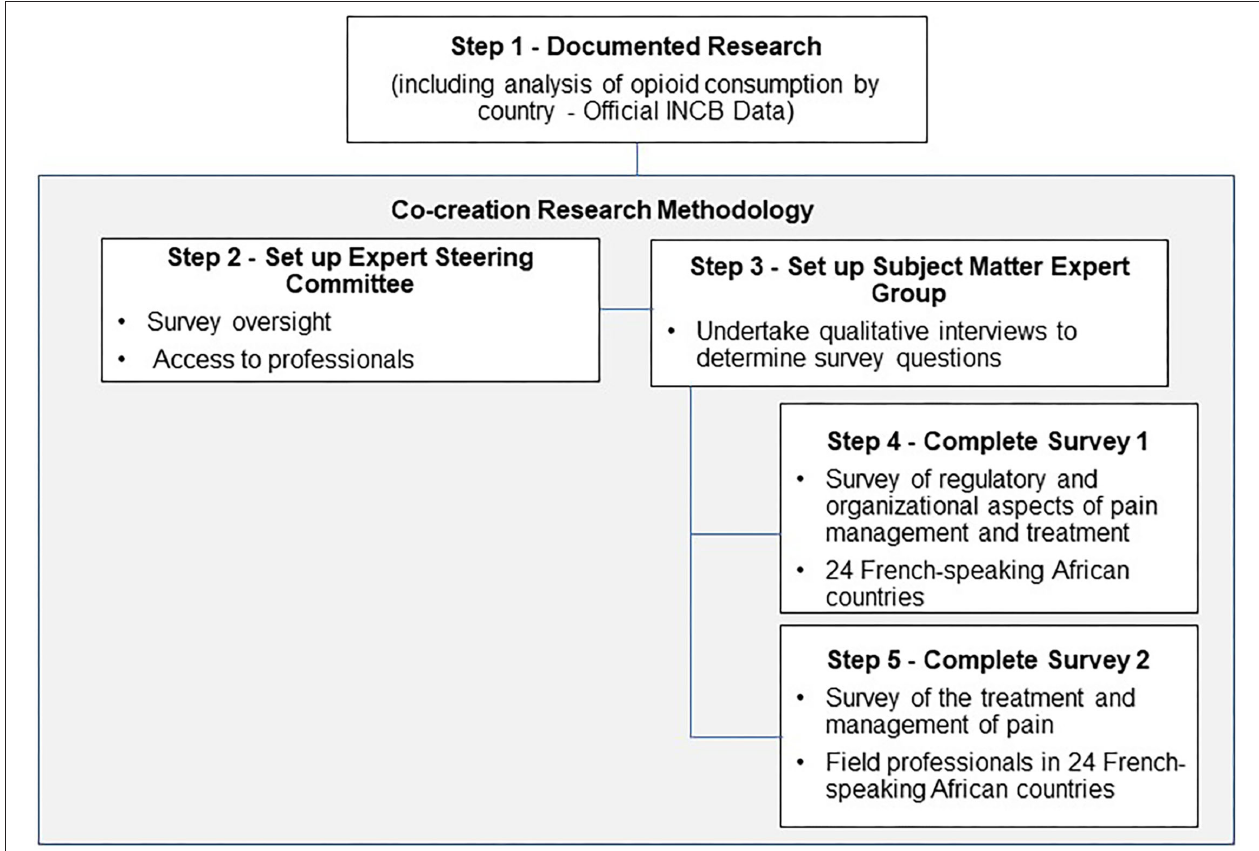
FIGURE 1 | Components of the research